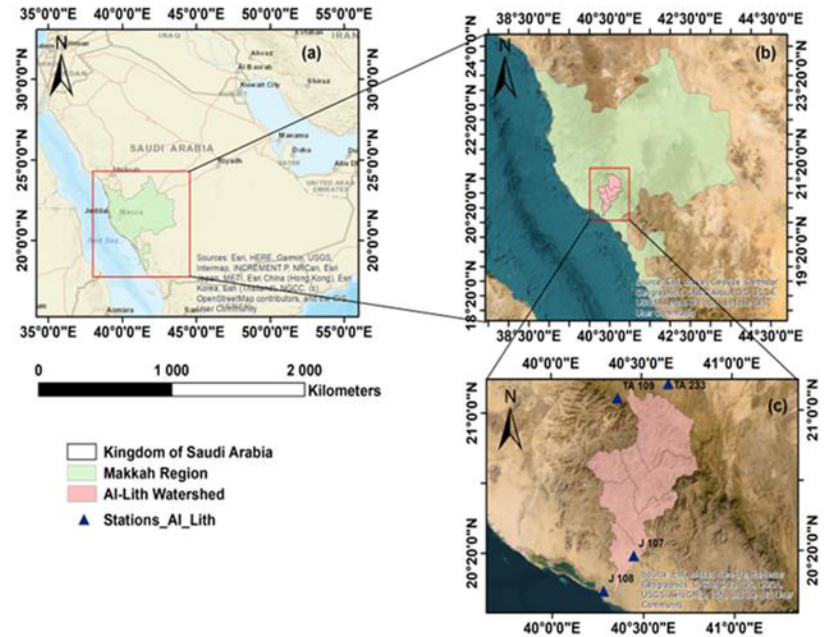
Figure 1. Geographical location of the Al-Lith Watershed: ( a ) Kingdom of Saudi Arabia; ( b ) Makkah Region; and ( c ) the Al-Lith Watershed.